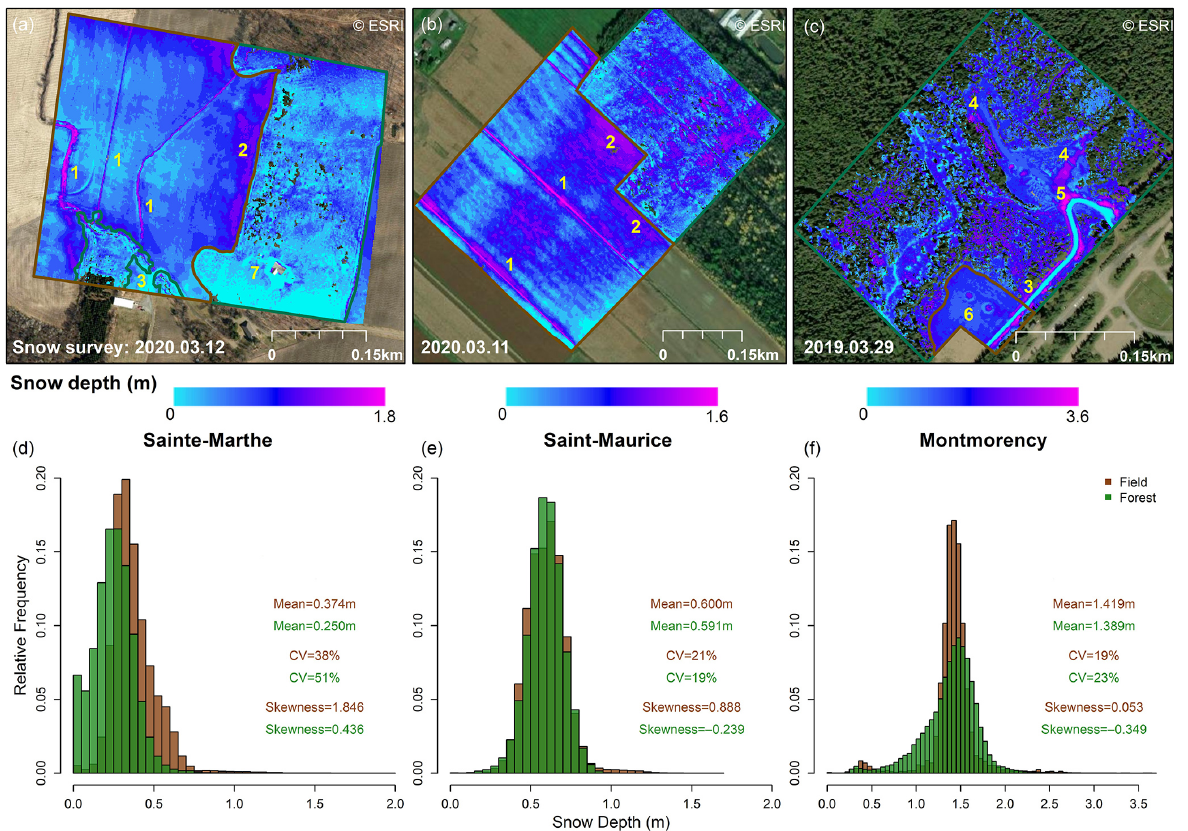
Figure 4. UAV-lidar-derived snow depth maps (grid size 1.4m) and histograms of snow depth distribution. (a, d) Sainte-Marthe map with snow surveying date and histogram; (b, e) Saint-Maurice map with snow surveying date and histogram; (c, f) Montmorency map with snow surveying date and histogram. Field and forest areas are demarcated with brown and green colors in snow depth maps, respectively. Histograms are derived according to these boundaries. Areas 1 to 7 are discussed in the